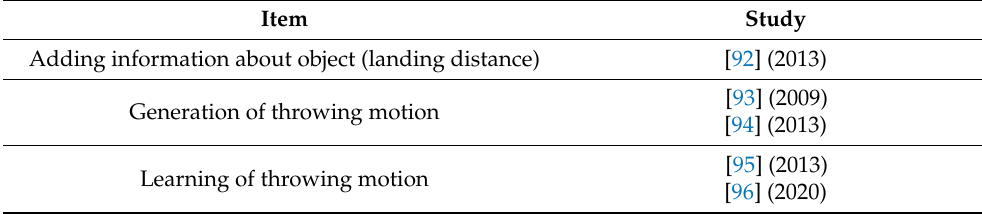
Table 6. Design studies on the throwing motion of